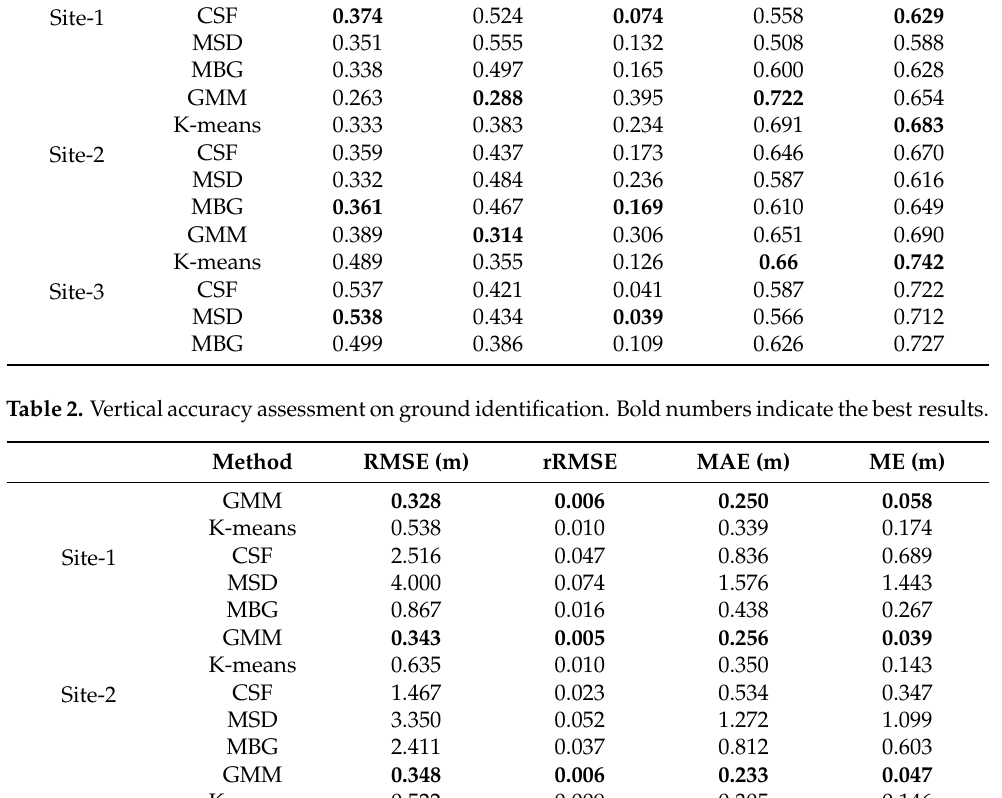
Table 1. Classification accuracy assessment on ground identification. Bold numbers indicate the best results. Method TP TI